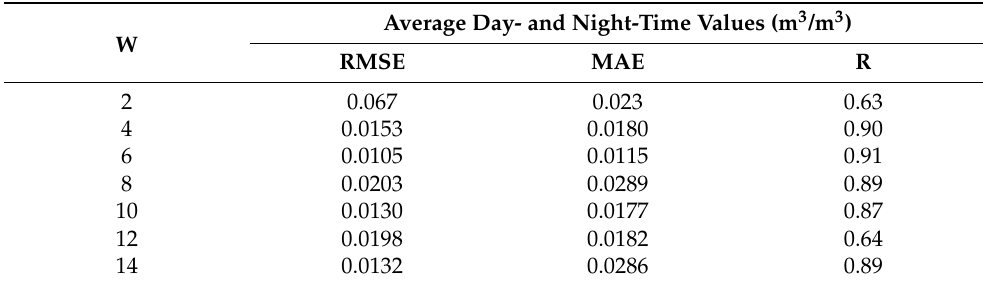
Table 3. Test window size between corrected variables and descriptive variables (original value).